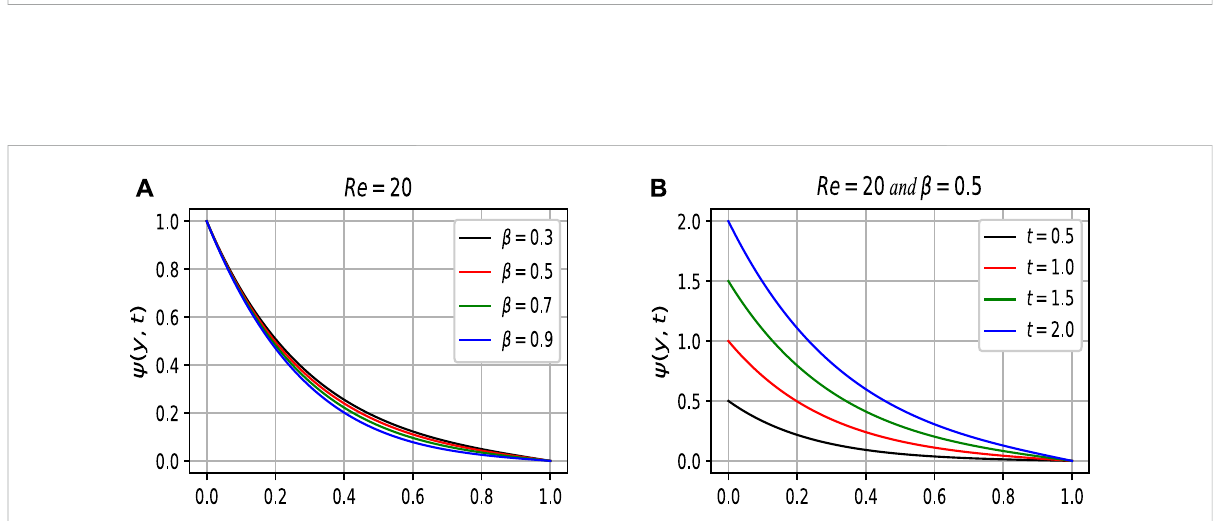
FIGURE 7 The behaviour of the boundary layer temperature as the parameters β and time ŧ